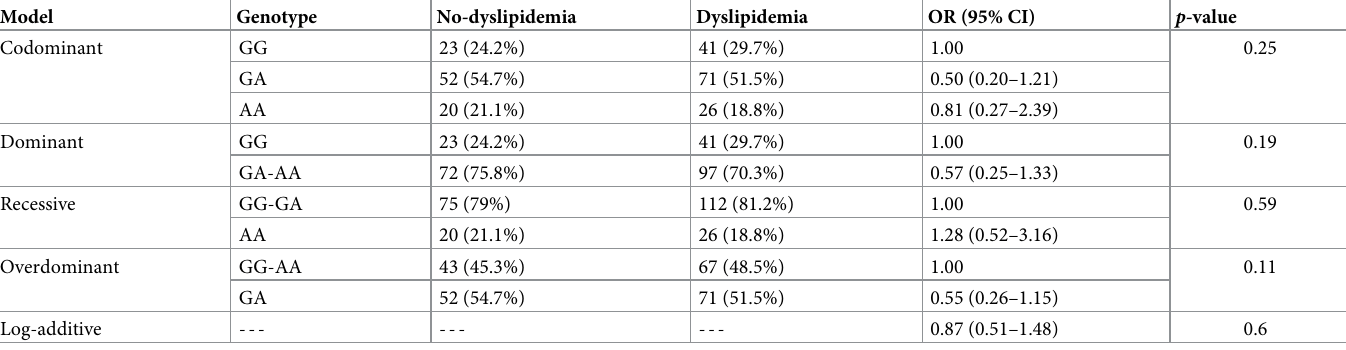
Table 6. Polymorphism rs1761667 association with response dyslipidemia based on "SNPStats" analysis tool.